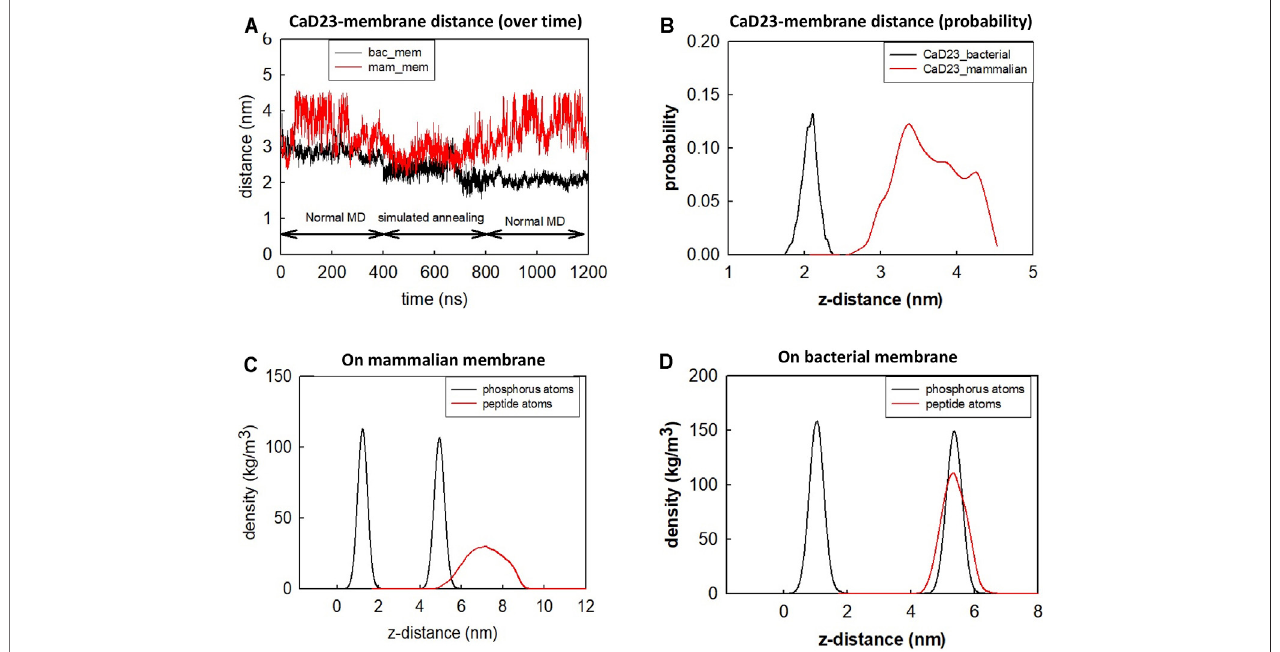
FIGURE 3 | Molecular dynamics simulation of CaD23 on model mammalian and bacterial membranes. Each simulation was run for 400 ns at 300 K, followed by another 400 ns using simulated annealing (SA) to accelerate phase space sampling, fi nally followed by a further 400 ns simulation to obtain equilibration. (A) The graph showing the distance between CaD23 and mammalian or bacterial membrane over 1,200 ns CaD23 is shown to be closer to the bacterial membrane than to the mammalian membrane, suggesting a stronger interaction between CaD23 and the bacterial membrane. (B) The probability distribution of the peptide-membrane distance in the last 400 ns, demonstrating a closer distance of CaD23 to the bacterial membrane than to the mammalian membrane. (C-D) Density distributions of the CaD23 with respect to the phosphate groups of the bilayer membranes. The analysis is based on the last 400 ns